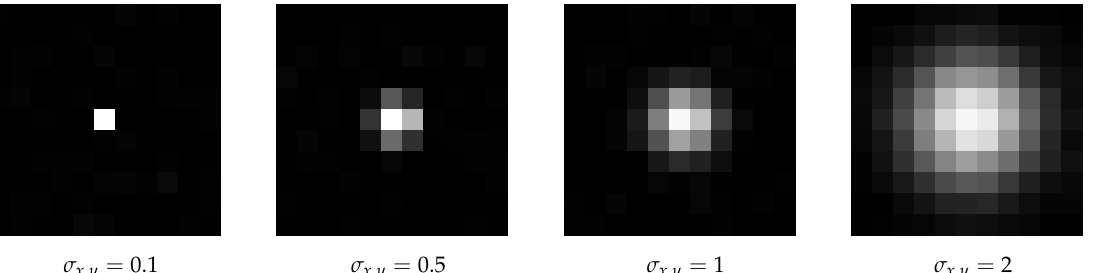
σ x , y = 0.1 Figure 9. Example images of the different particle sizes used in Figure 8.